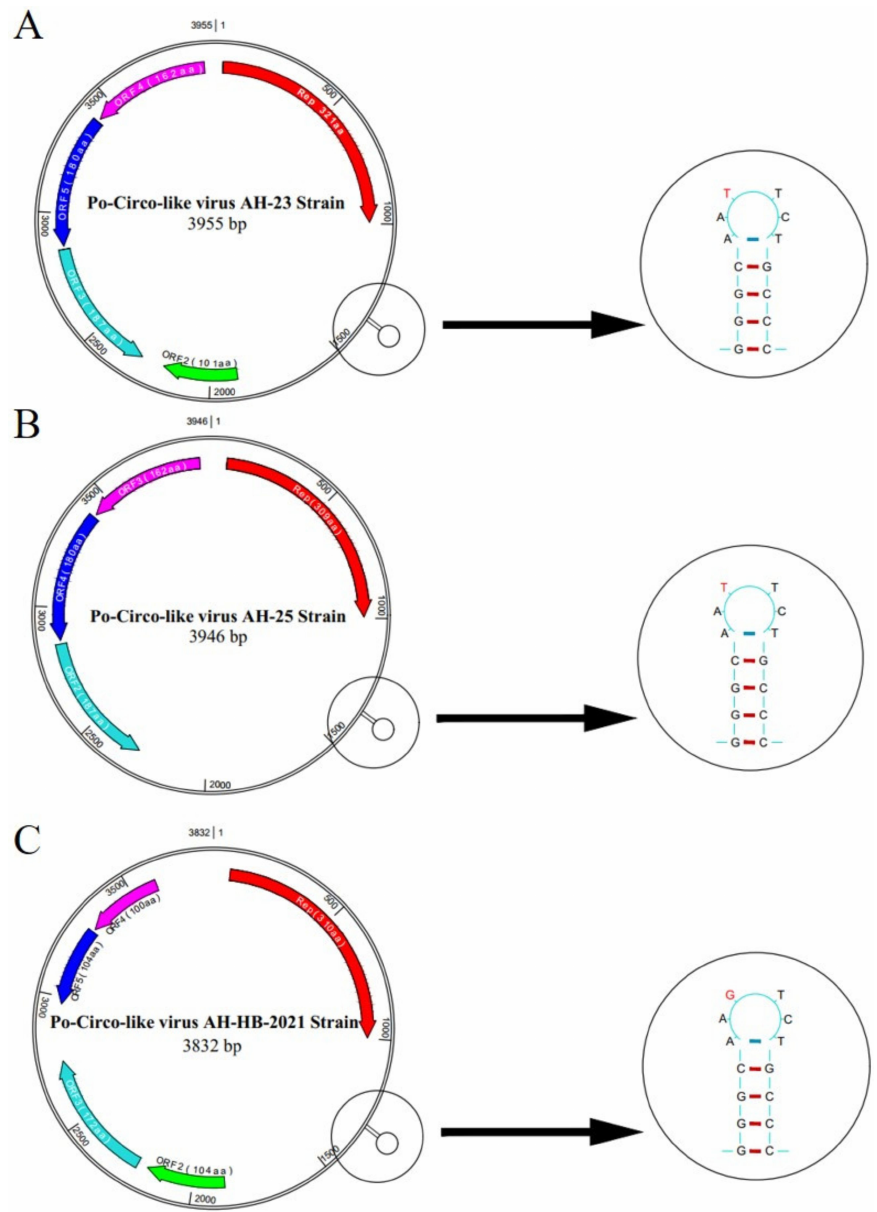
Figure 2. Predicted genomic structural characteristics of PCLV-AH-23, PCLV-AH-25 and PCLV-AH- HB-2021. PCLV-AH-25 only four potential ORFs were present, whereas in strain PCLV-AH-23 and PCLV-AH-HB-2021, the locations of five potential ORFs were identified„ one of which contained the opposite transcriptional direction. A significant T7G mutation was found in the stem loop of